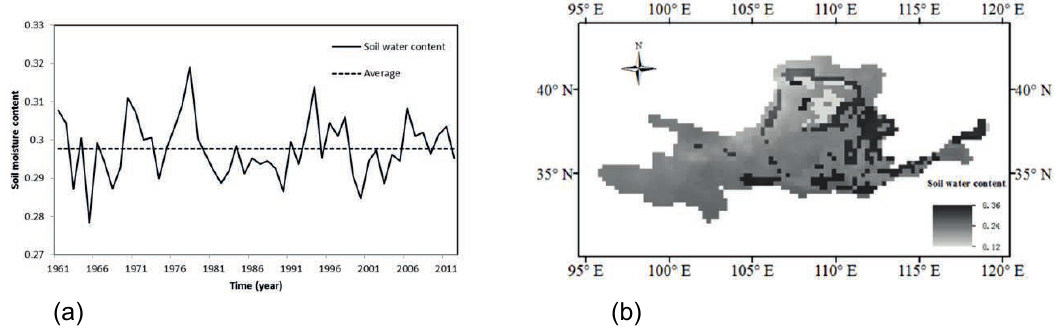
Fig. 2 (a) Variation of mean surface soil water content for the Yellow River basin, and (b) spatial distribution of average surface soil water content during 52